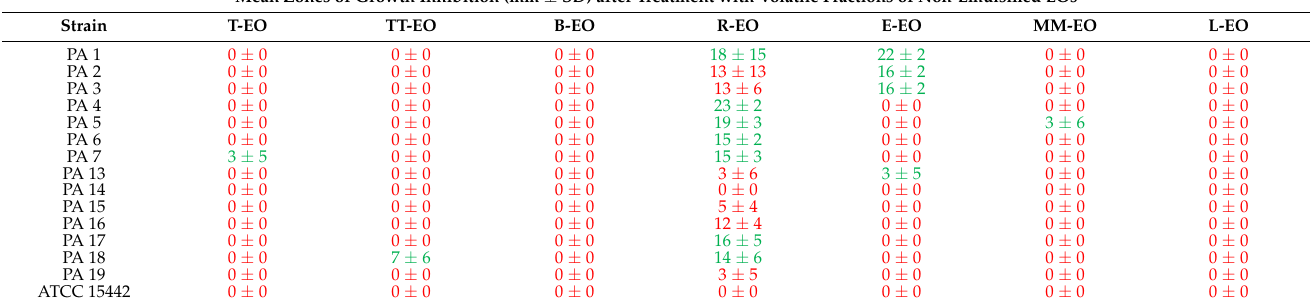
Table 6. Mean diameters of inhibition zones (mm ± standard deviation) after treatment of planktonic forms of P. aeruginosa clinical (PA 1–7, PA 13–19) and the reference (ATCC 15442) strains with volatile fractions of non-emulsified EOs assessed with the inverted Petri dish method. T-EO, thyme oil; TT-EO, tea tree oil; B-EO, basil oil; R-EO, rosemary oil; E-EO, eucalyptus oil; MM-EO, menthol mint oil; L-EO, lavender oil. According to their susceptibility to R-EO, the strains were divided into two groups for seven or eight samples per group. For the rest of the EOs, the zone equal to 0 mm was the parameter for the low susceptibility group and higher than 0 mm for the high susceptibility one. The groups are marked as follows: red, low susceptibility among the tested strains; green, high susceptibility among the tested